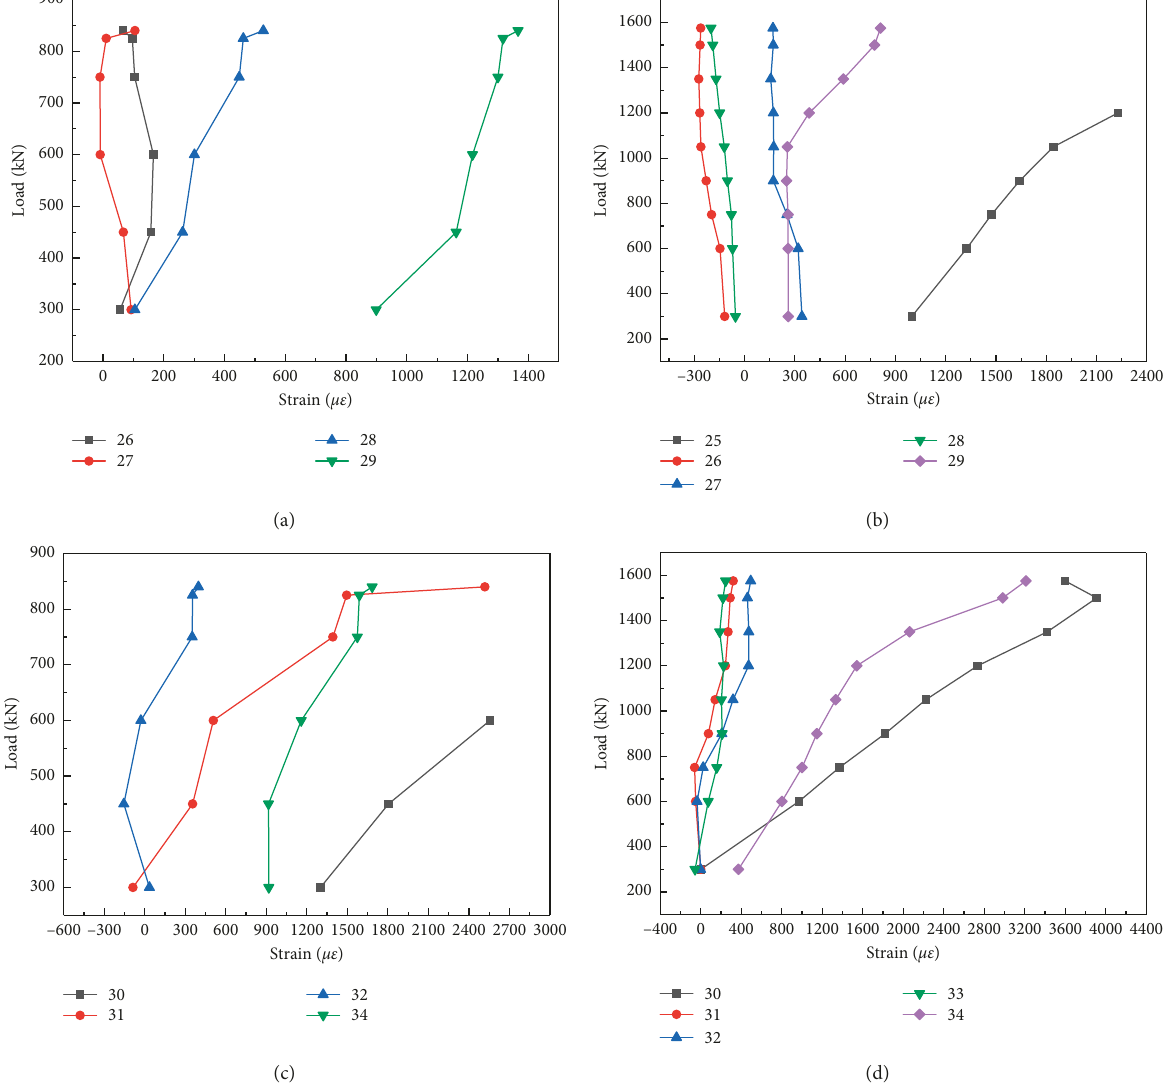
Figure 25: Comparison of load-strain curves of horizontal beams in Models 1 and 2. (a) A-axis horizontal rods of Model 1. (b) A-axis horizontal rods of Model 2. (c) C-axis horizontal rods of Model 1. (d) C-axis horizontal rods of Model